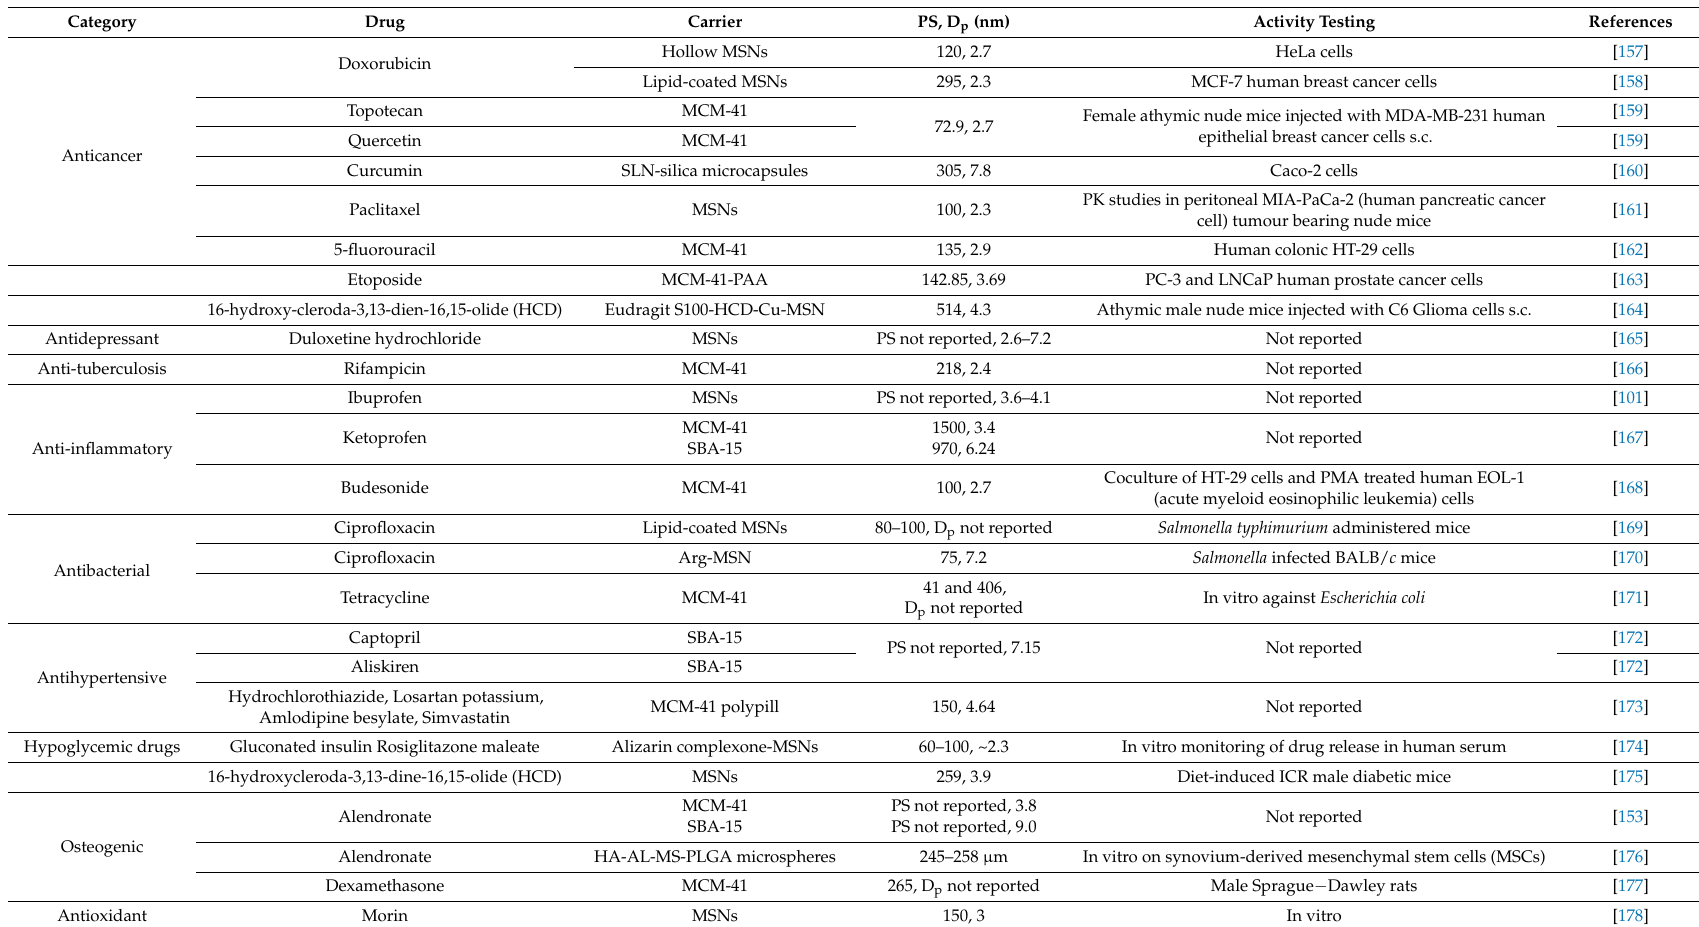
Table 6. List of some biomedical applications of